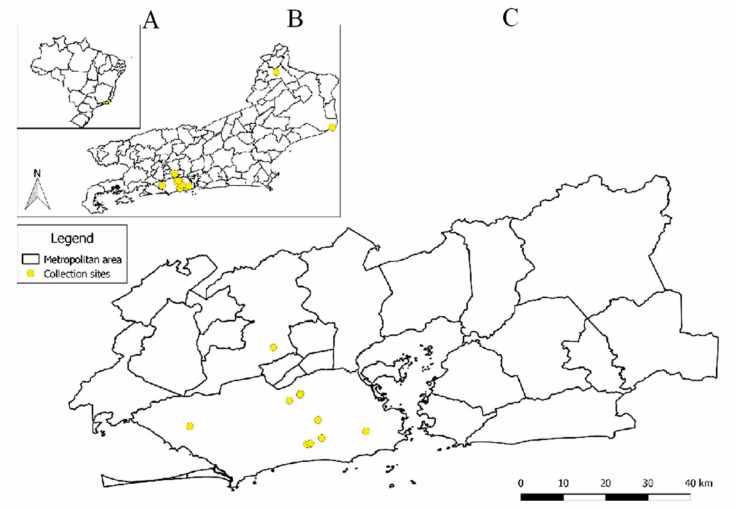
Figure 3. Geographic distribution of trapping locations. ( A ) Brazil; ( B ) Rio de Janeiro state; ( C ) Metropolitan region.